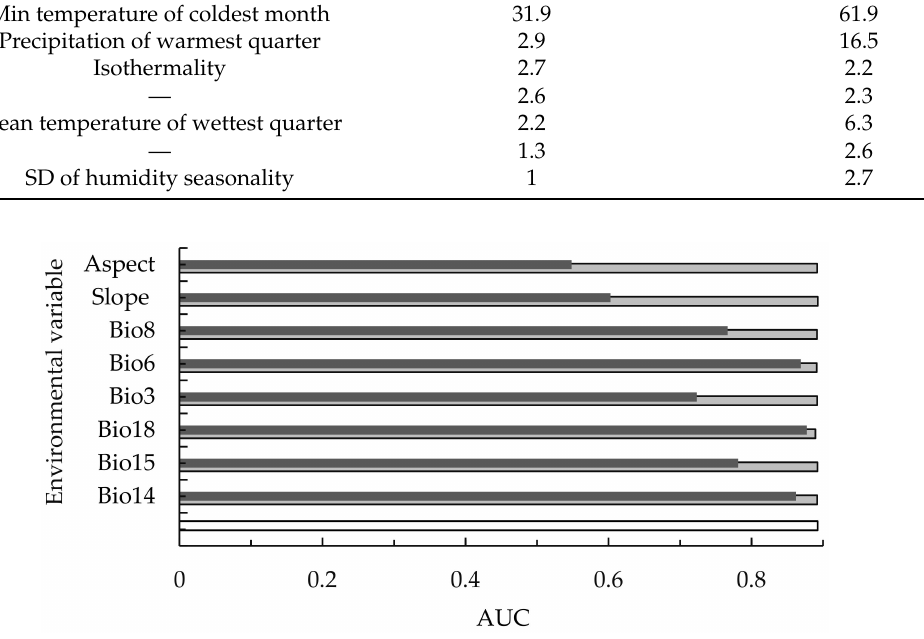
Figure 2. Jackknife test of MaxEnt